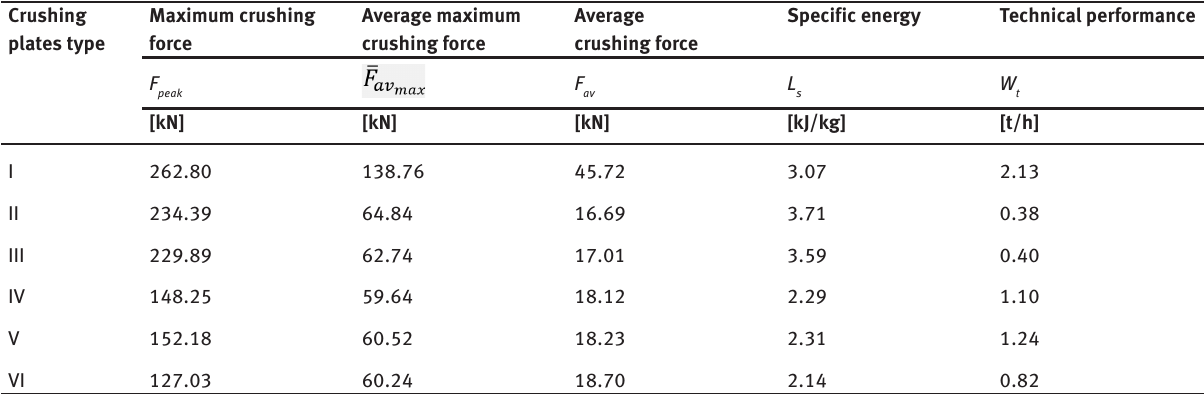
Table 4: Crushing forces, crushing energy and technical performance Crushing plates